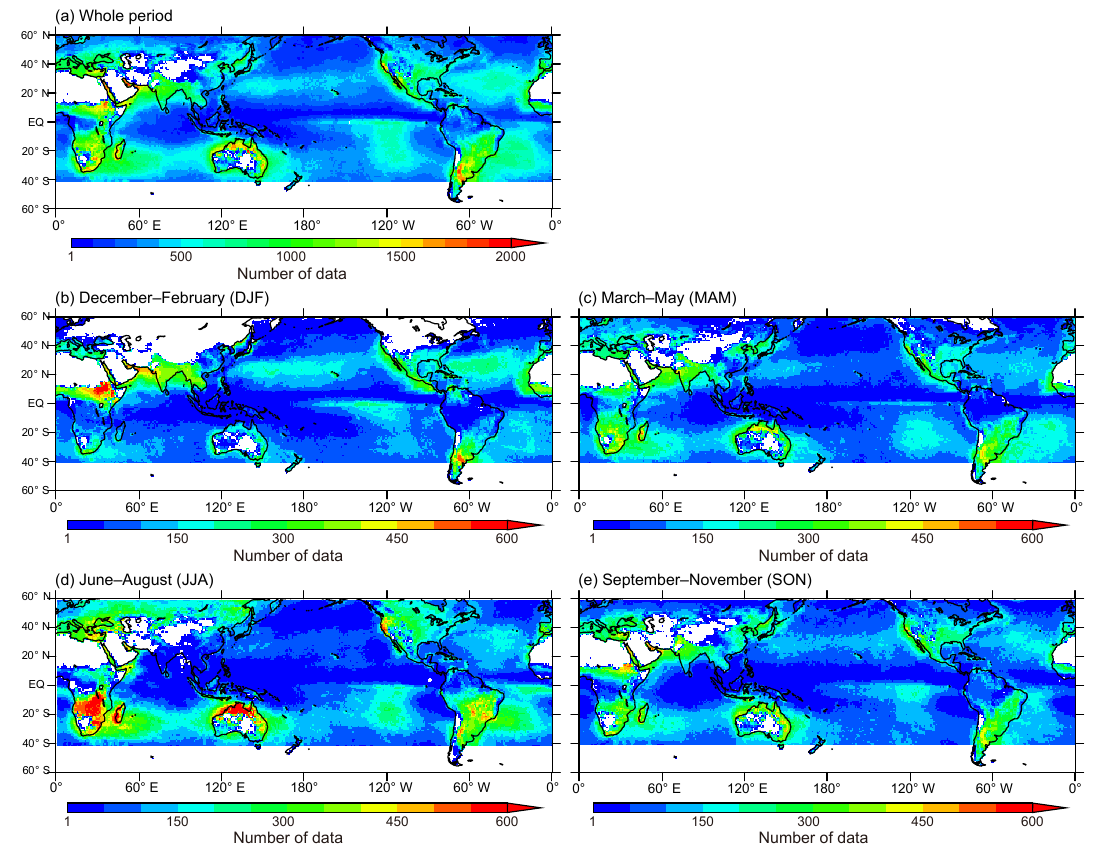
Figure 1. Horizontal distribution of the number of NRL-UND MODIS AOD data assimilated in RA in (a) the whole reanalysis period